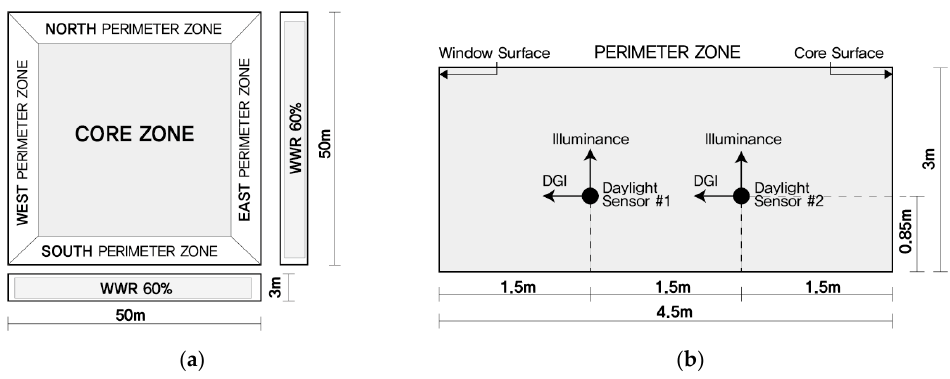
Figure 5. ( a ) Floor plan of the EnergyPlus Simulation Model; ( b ) location of the daylight sensor.